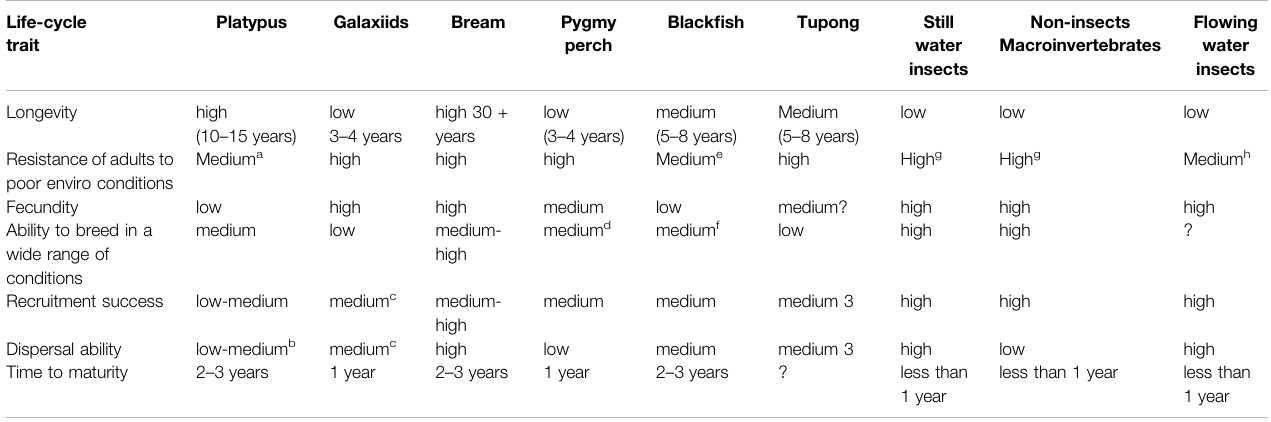
TABLE 3 | Life-history traits of priority environmental values in the Werribee River. Life-cycle